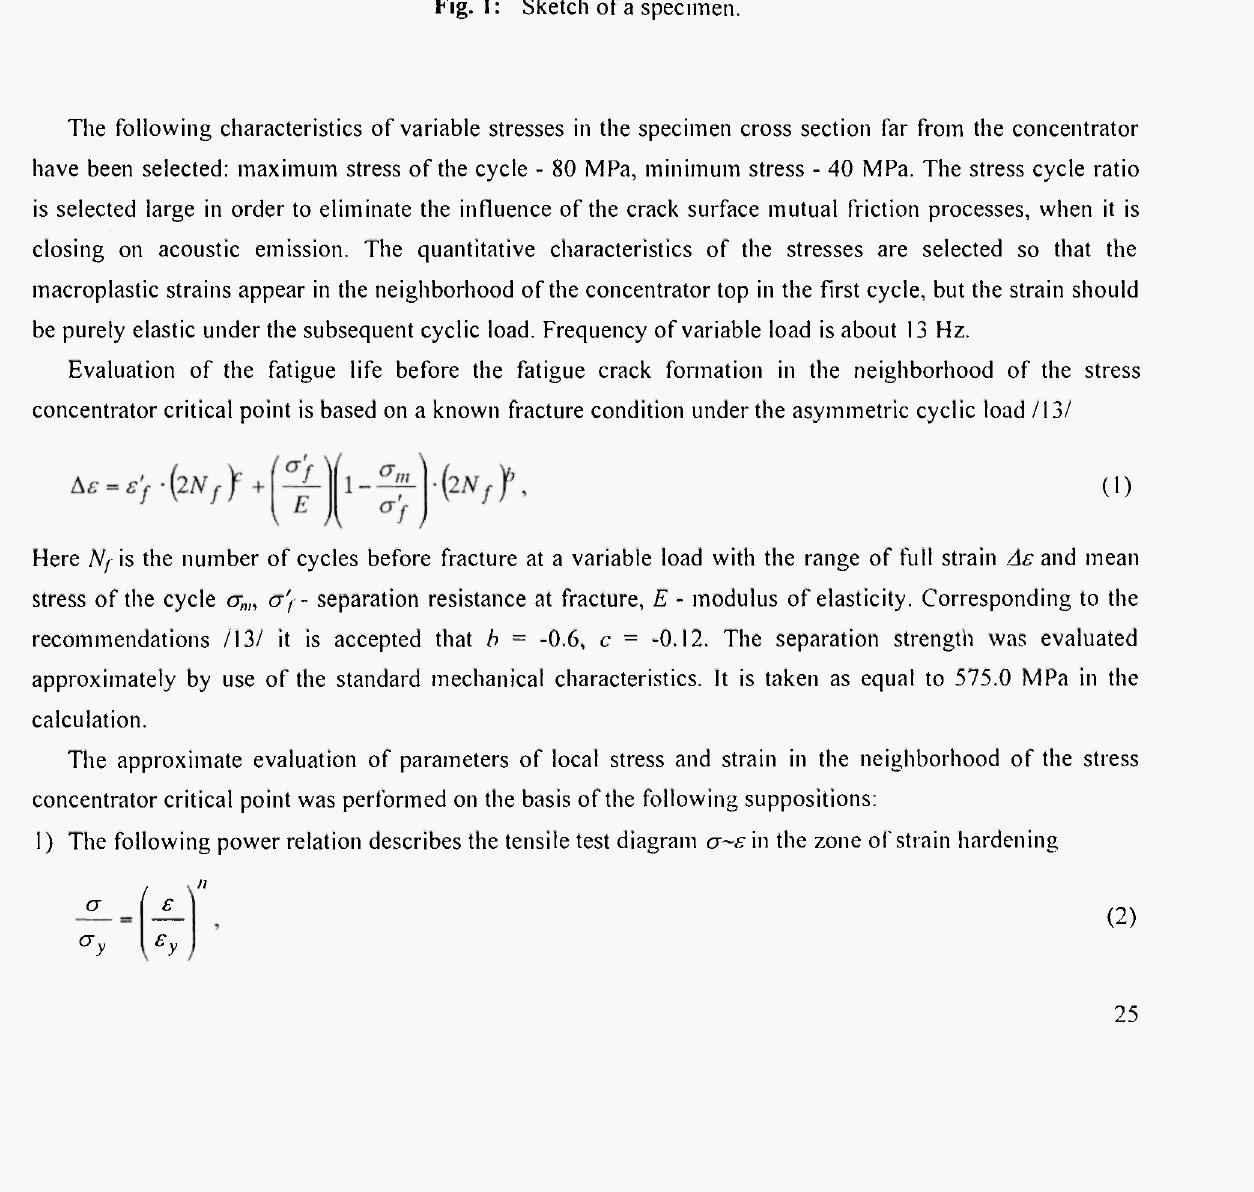
Fig. 1: Sketch of a